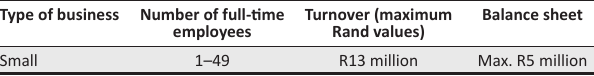
TABLE 1: Schedule of size standards of small businesses in South